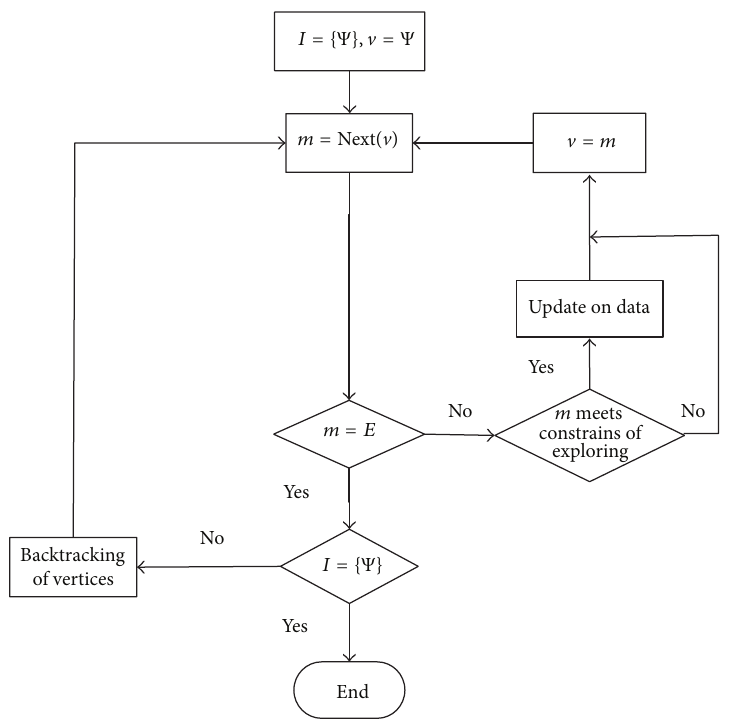
Figure 10: Flowchart of the complete algorithm.